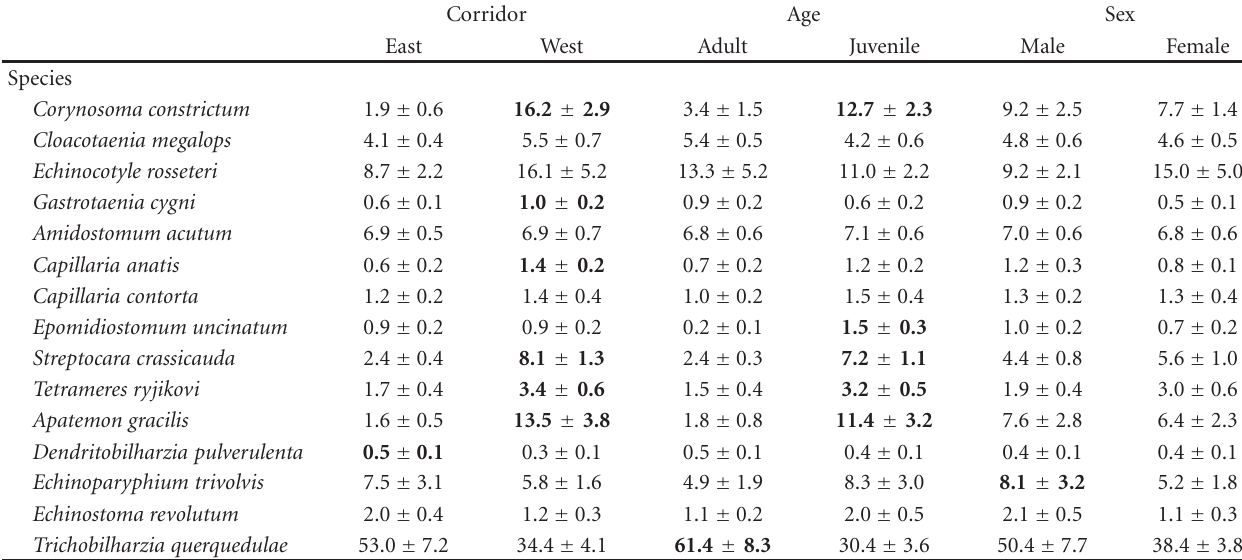
Table 3: Abundance values ( x ± SE) for the 15 common/intermediate by host migratory corridor, host age, and host sex for 184 blue-winged teal collected in Florida, Louisiana, and Texas from 21 September through 30 October